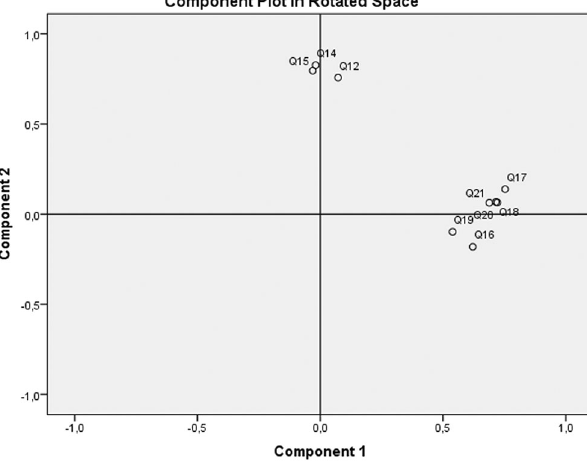
Figure 1. Principal Component Analysis (PCA): circle correlation between questions and components after Varimax rotation. Projection of functional VL questions (Q12, Q14, Q15) and interactive-critical VL questions (Q16-Q21) on two components (Factor 1 and Factor 2). Variables that are close to each other are significantly positively correlated.